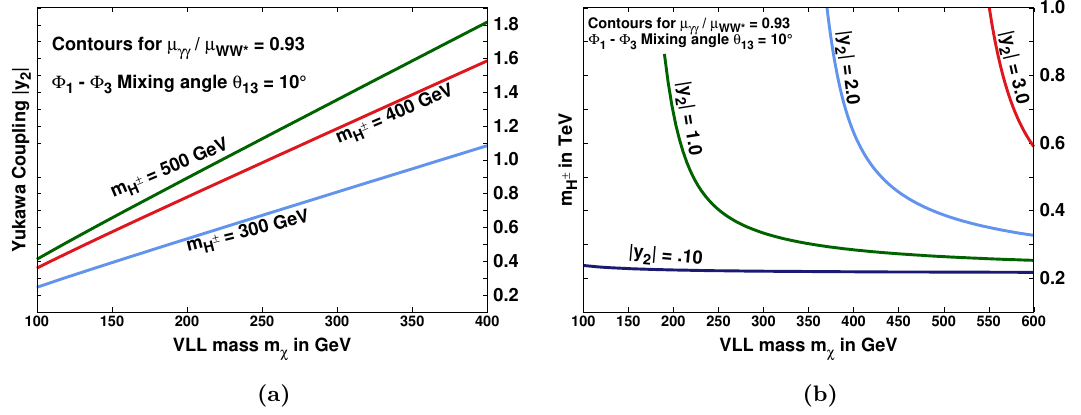
/µ = 0 . 93 +0 . 17 [59] for θ 13 = 10 ◦ are drawn − 0 . 16 WW? γγ